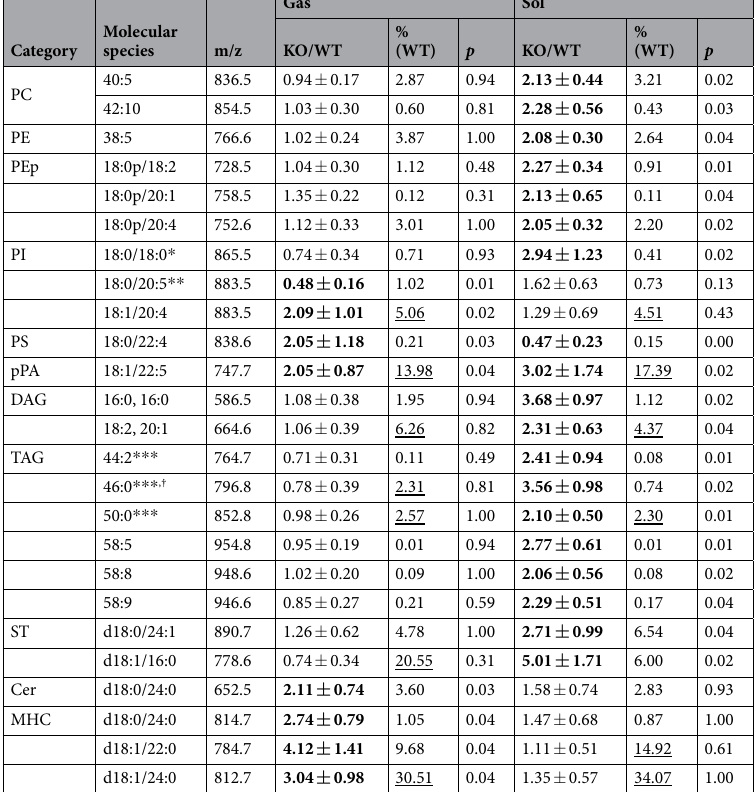
Table 2. Peak area ratio (KO/WT) of individual lipid species s howing significant changes ( > 2-fold, p < 0.05, bold) either in gastrocnemius (Gas) or soleus (Sol) tissue samples along with p value. Relative abundance is expressed with peak area percentage (%) of each species within the corresponding lipid class and the underlined species are the relatively high abundance species ( > 100%/# of identified species within the category). Marked with extra symbols are common species reported with the significant change (p < 0.05) in kidney ( * ), lung ( ** ), and liver ( *** ) of p53 KO mice model, and skeletal muscle tissue ( † ) of diabetic rat model. Under the assumption that MS intensity of lipids is not significantly affected by the. length and degree of unsaturation of acyl chains, peak area ratios can be considered as the relative values corresponding to 1 pmol of